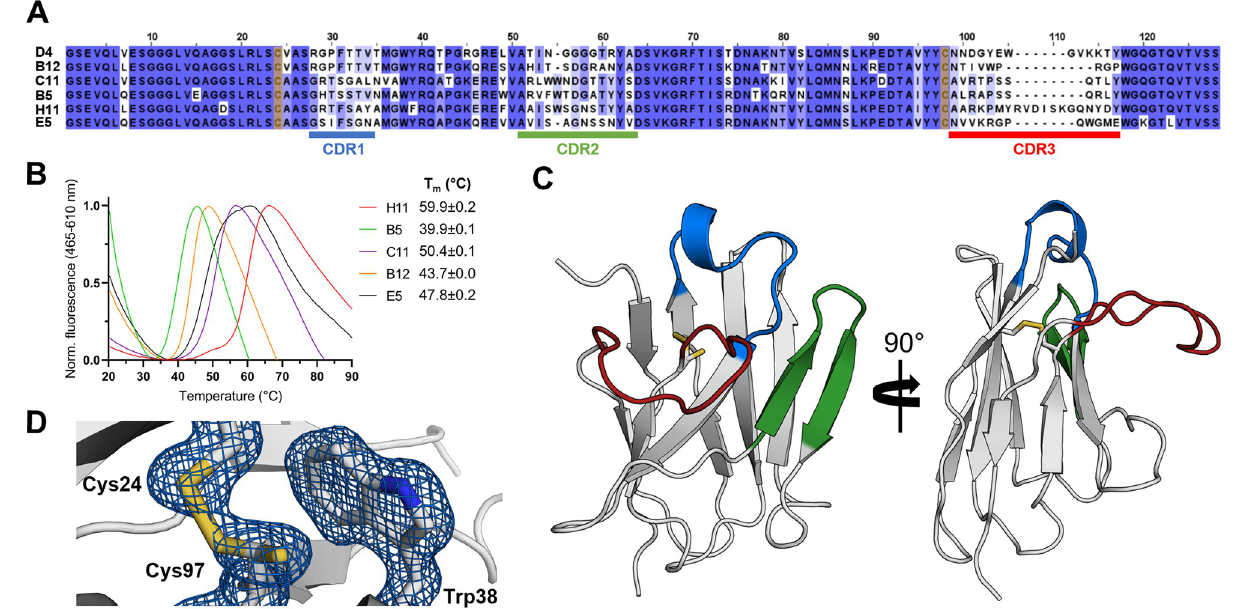
Fig 2. Anti-Arc nanobodies. A Sequence alignment reveals the location of the three CDRs, highlighting the long CDR3 of NbArc-H11. Sequences are coloured by conservation, and Cys24 and Cys92 (Kabat numbering) are highlighted in yellow. The alignment was produced using Clustal Omega [71] and JalView [72]. B Determination of NbArc T m using DSF (N = 3). The T m of NbArc-D4 could not be determined. C 1.42- Å crystal structure of NbArc-E5. Colouring of CDRs is the same as in panel A . D The conserved central disulphide bond, formed by oxidation Cys24 and Cys97, packs against Trp38 and is partially reduced. Electron density is shown as a blue mesh at 1.5 σ